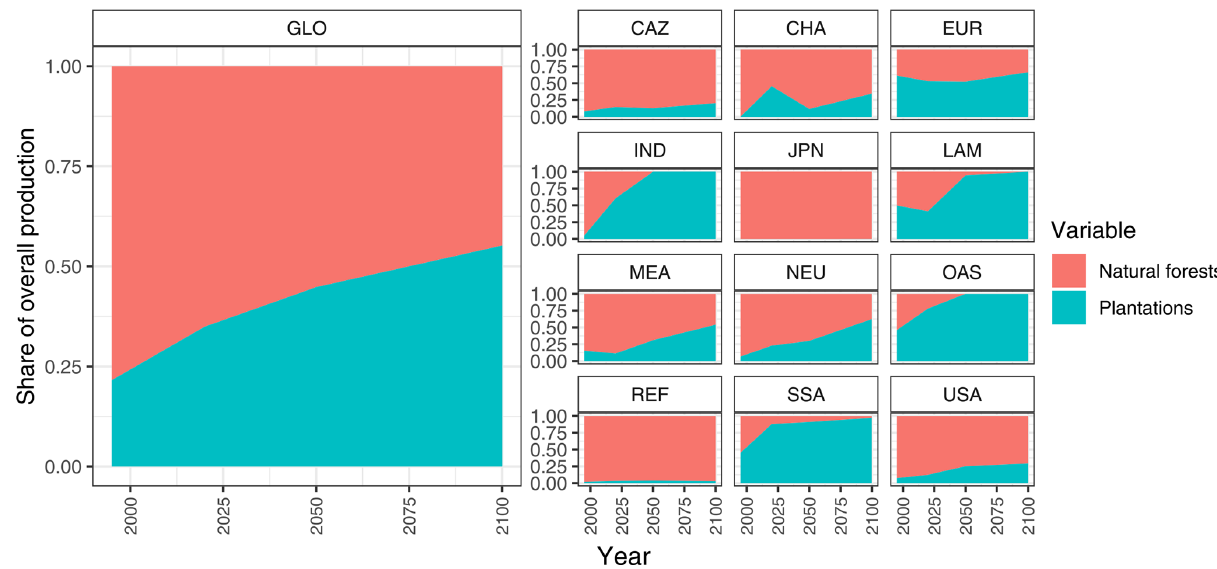
Figure A5. Modeled contribution of timber harvested from natural forests and plantations to industrial roundwood and wood fuel production in the forestry scenario (1995–2100).